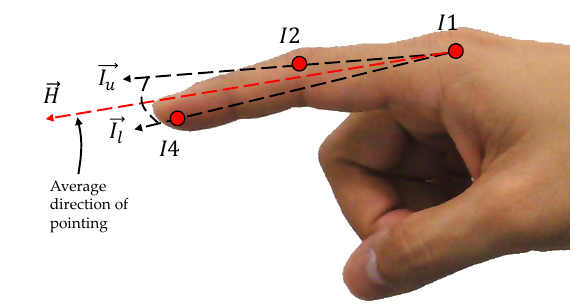
Figure 17. Hand-pointing direction estimation.